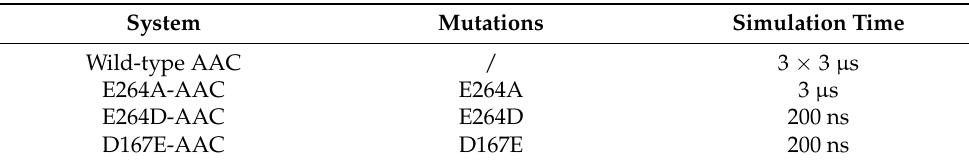
Table 2. Summary of simulations in the current work.